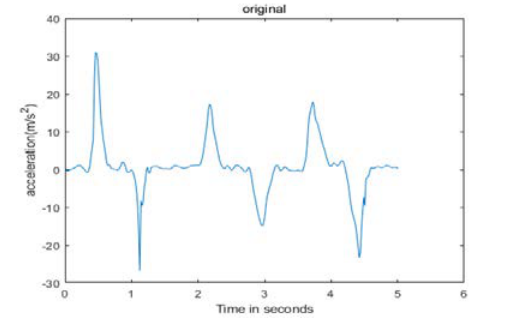
Fig. 5. Figure with original data.